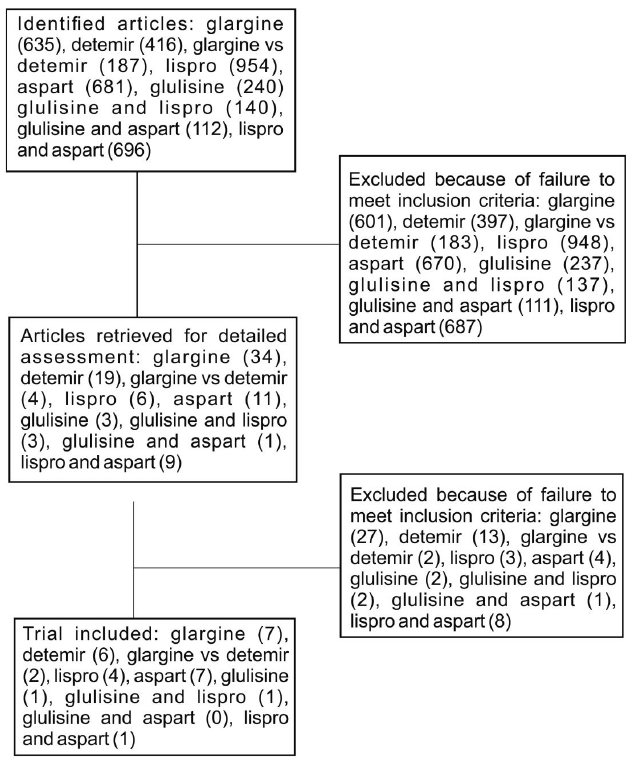
FIGURE 1 - Flowchart of the selection of randomized controlled trials included in our systematic review of long- and short-acting insulin